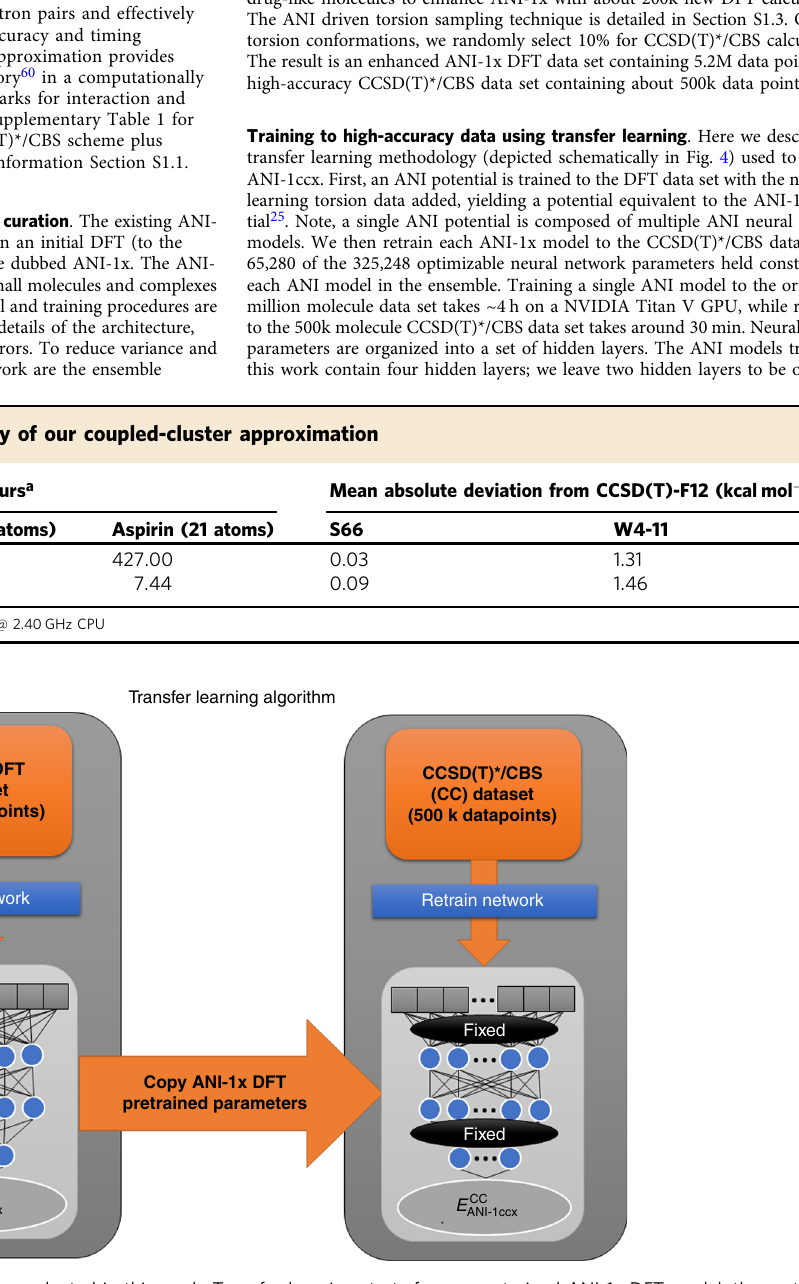
Fig. 4 Diagram of the transfer learning technique evaluated in this work. Transfer learning starts from a pretrained ANI-1x DFT model, then retrains to higher accuracy CCSD(T)*/CBS data with some parameters fi xed during training